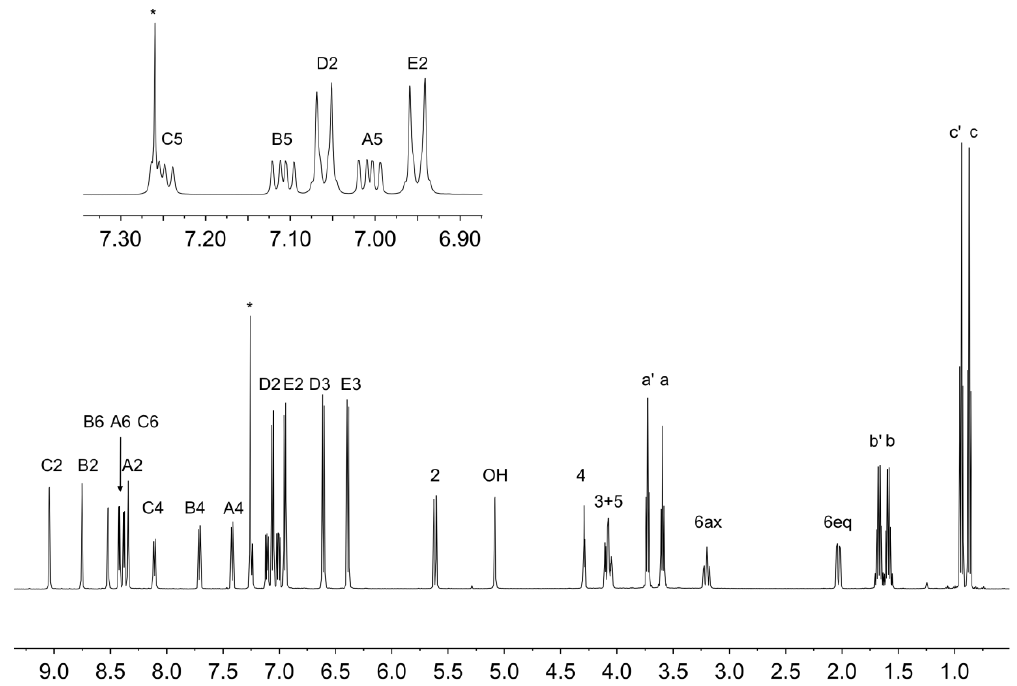
Figure 7. 1 H NMR spectrum (500 MHz, CDCl 3 , 298 K) of compound 6b . See Figure 6 for atom labelling. * = residual CHCl 3 .